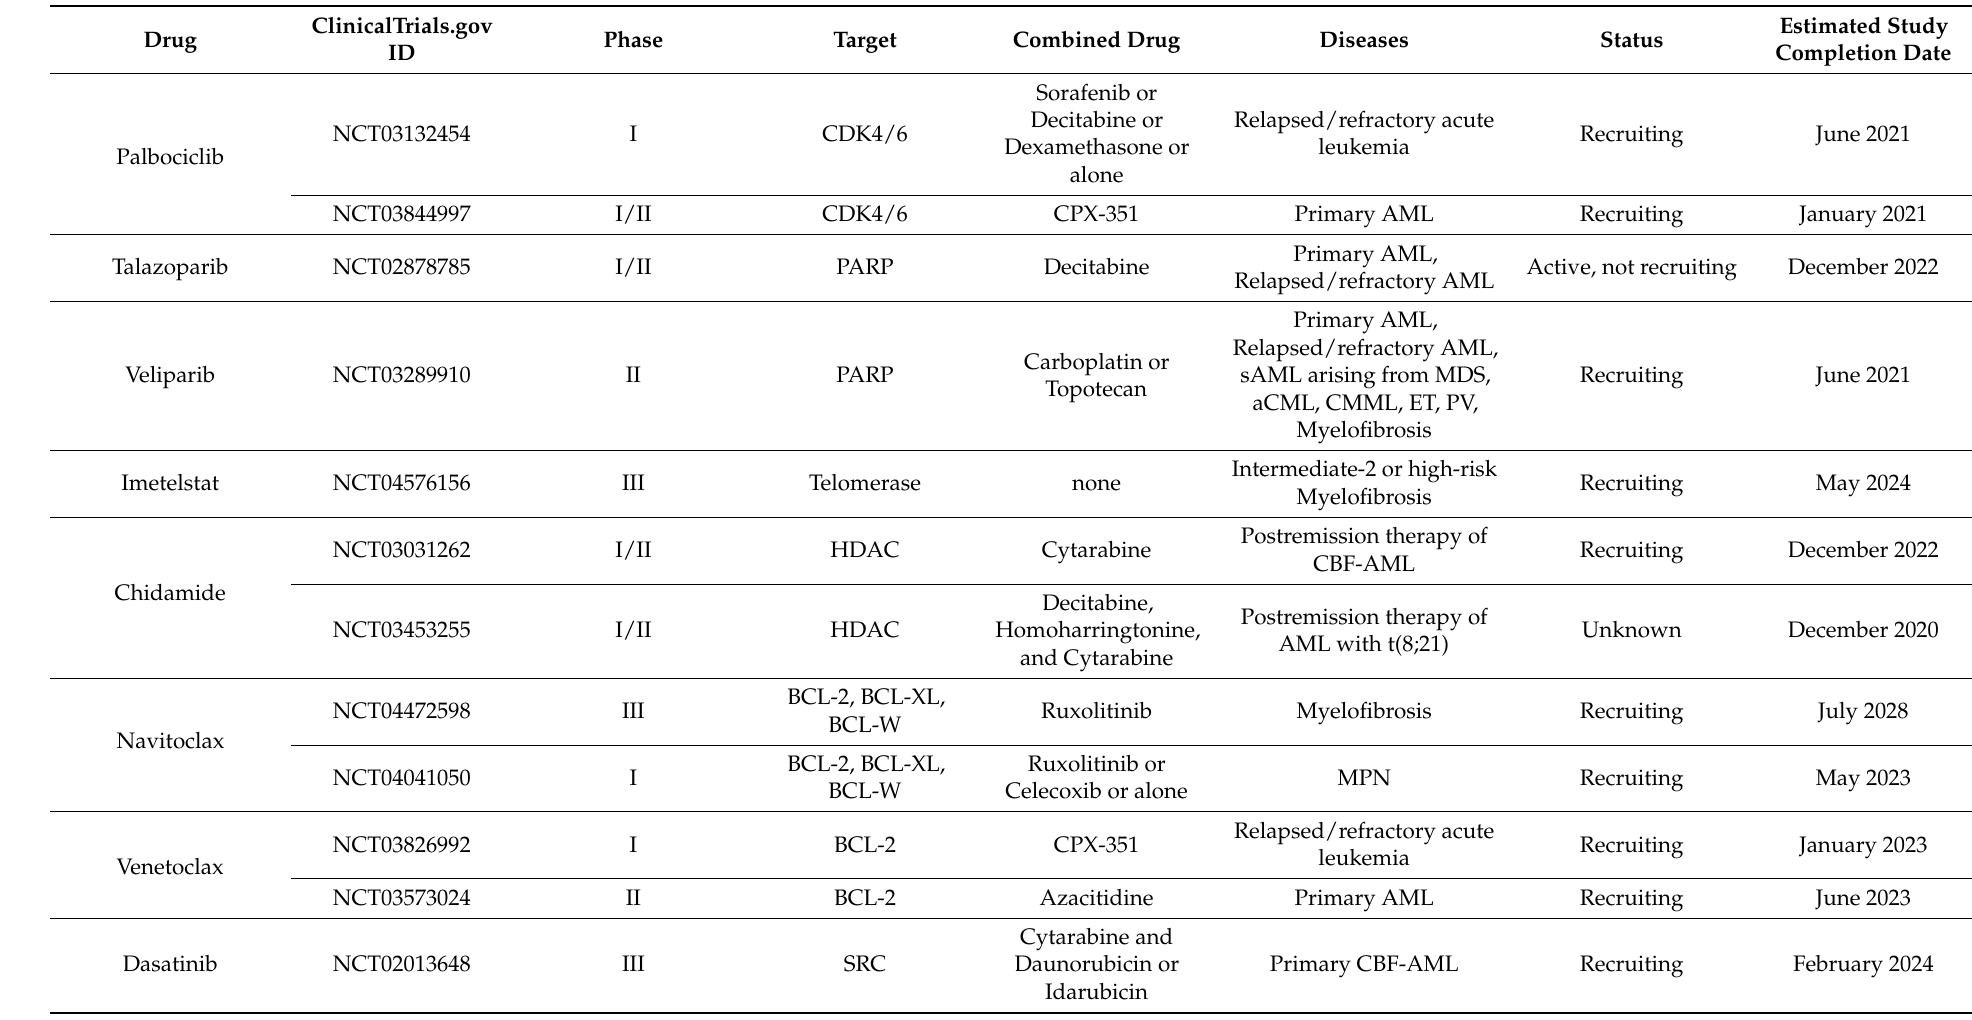
Table 1. Selected active clinical studies investigating senescence-associated drugs on myeloid